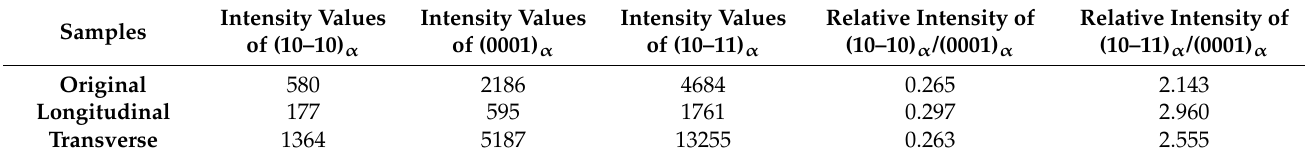
Table 2. Intensity values of main peaks of XRD analysis in Figure